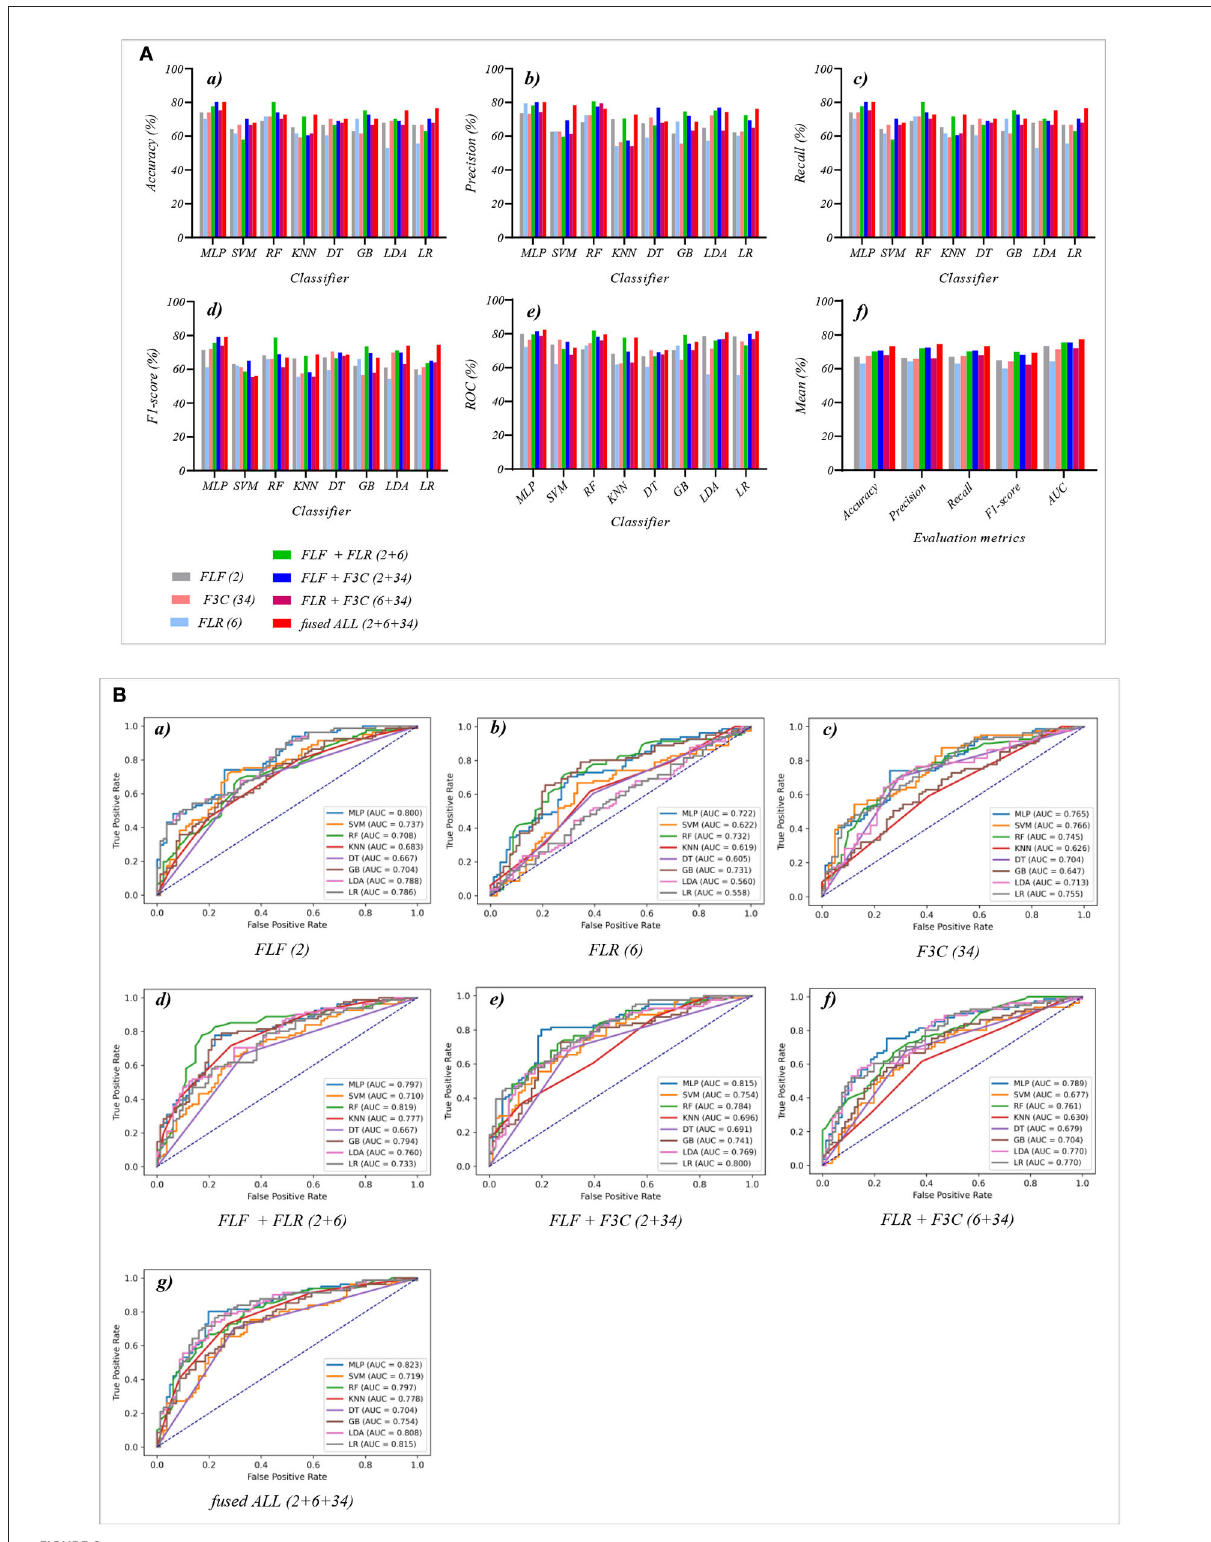
FIGURE6 The evaluation metrics pictures and ROCs of eight classifiers with seven fused features (three fused features and four fused combination features in Experiment 3). (A) The evaluation metrics pictures include (a) Accuracy, (b) Precision, (c) Recall, (d) F1-score, (e) AUC, and (f) Mean. (B) ROCs of the ML classifiers include (a) FLF (2), (b) FLR (6), (c) F3C (34), (d) FLF (g) FLF FLR F3C (2 6 + + + +